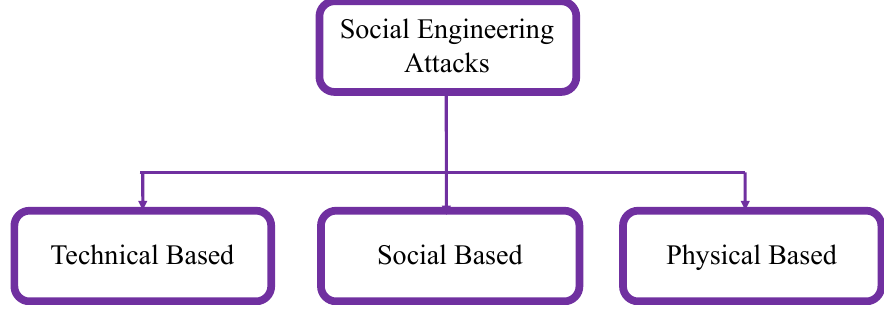
Figure 3. Social engineering attacks classification.